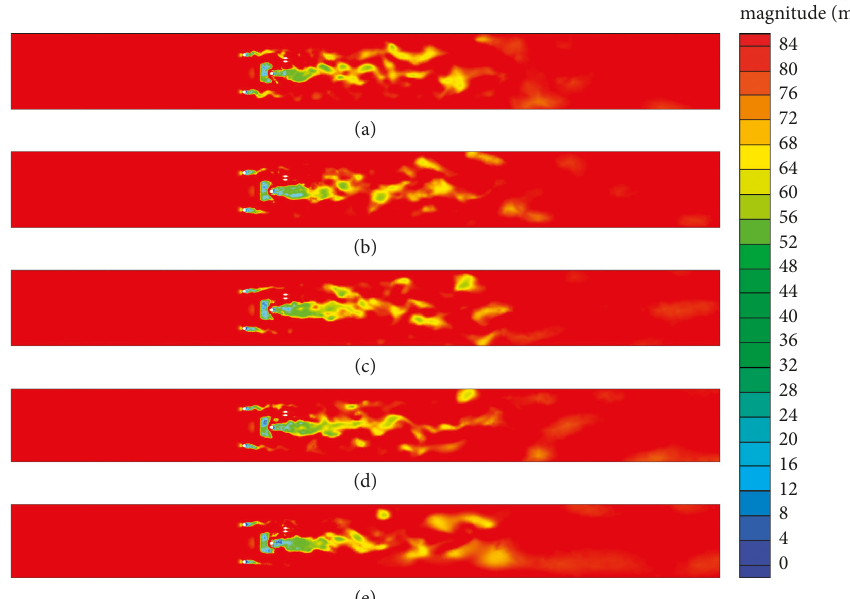
Figure 10: Average velocity amplitude of the pantograph using the (a) LES, (b) SAS, (c) IDDES sst-k ω , (d) DDES sst-k ω , and (e) DDES R-k ε models.